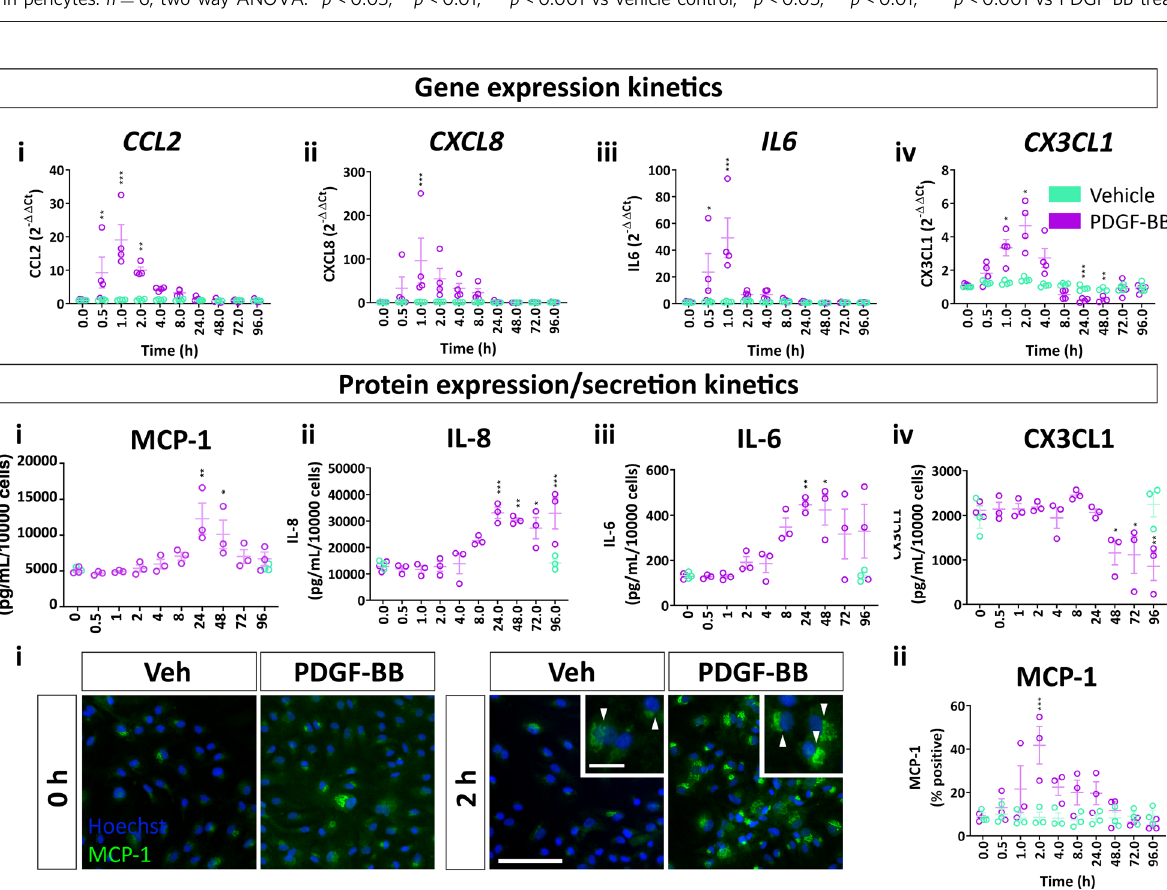
Fig. 7 PDGF-BB-dependent proliferation and protection from apoptosis are dependent on ERK signalling. Pericytes were grown to con fl uence, then treated with PDGF-BB (10ng/mL) for up to 96h, then fi xed at the endpoint and immunostained or RNA harvested for qPCR. EdU was added 24h prior to the endpoint. Quanti fi cation of b Ki67 protein and c MKI67 gene expression following PDGF-BB stimulation. Quanti fi cation of d EdU incorporation and e cell count